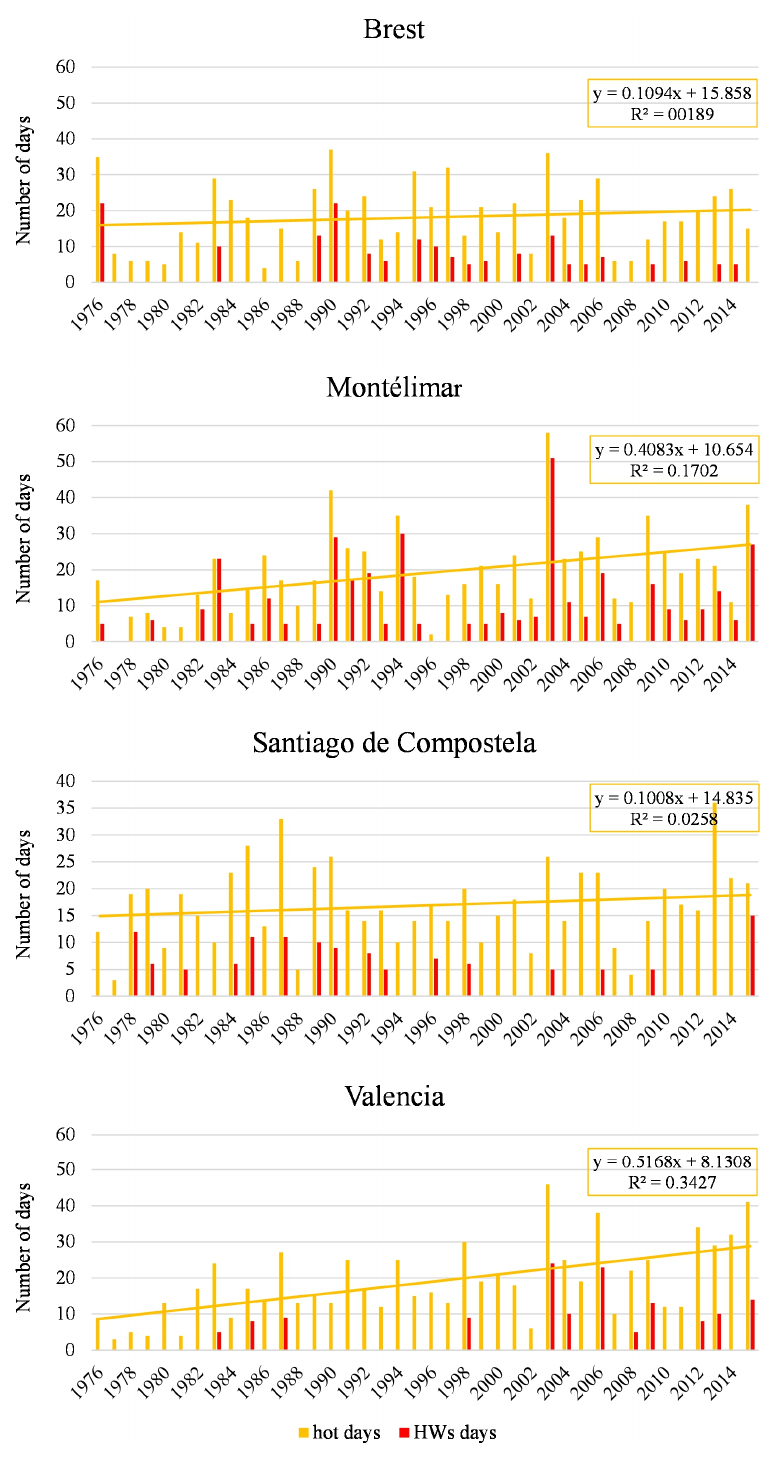
Figure 3. Examples of time series of hot days (with trend lines and equations) and HW days.